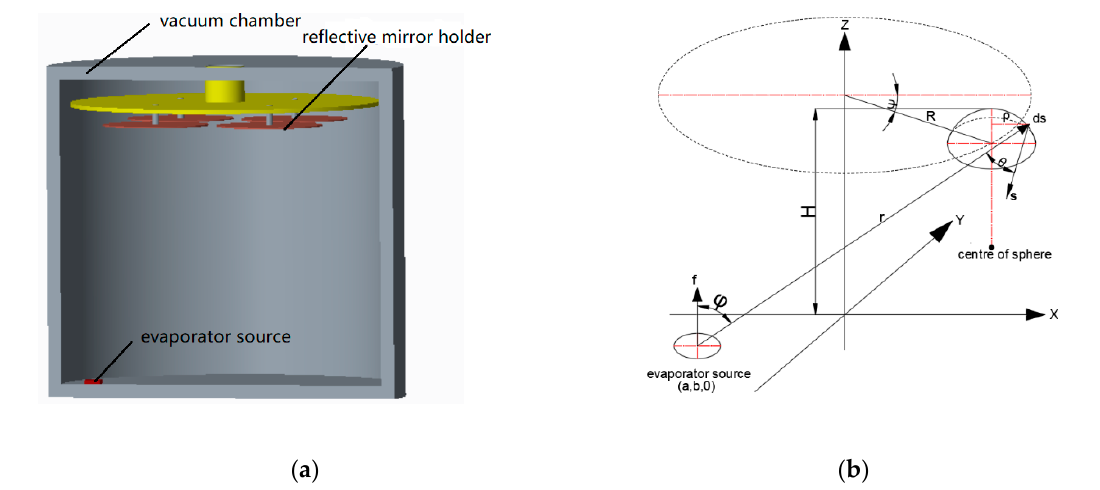
Figure 1. ( a ) Schematic diagram of the vacuum chamber. ( b ) Geometric configuration of the vacuum chamber.